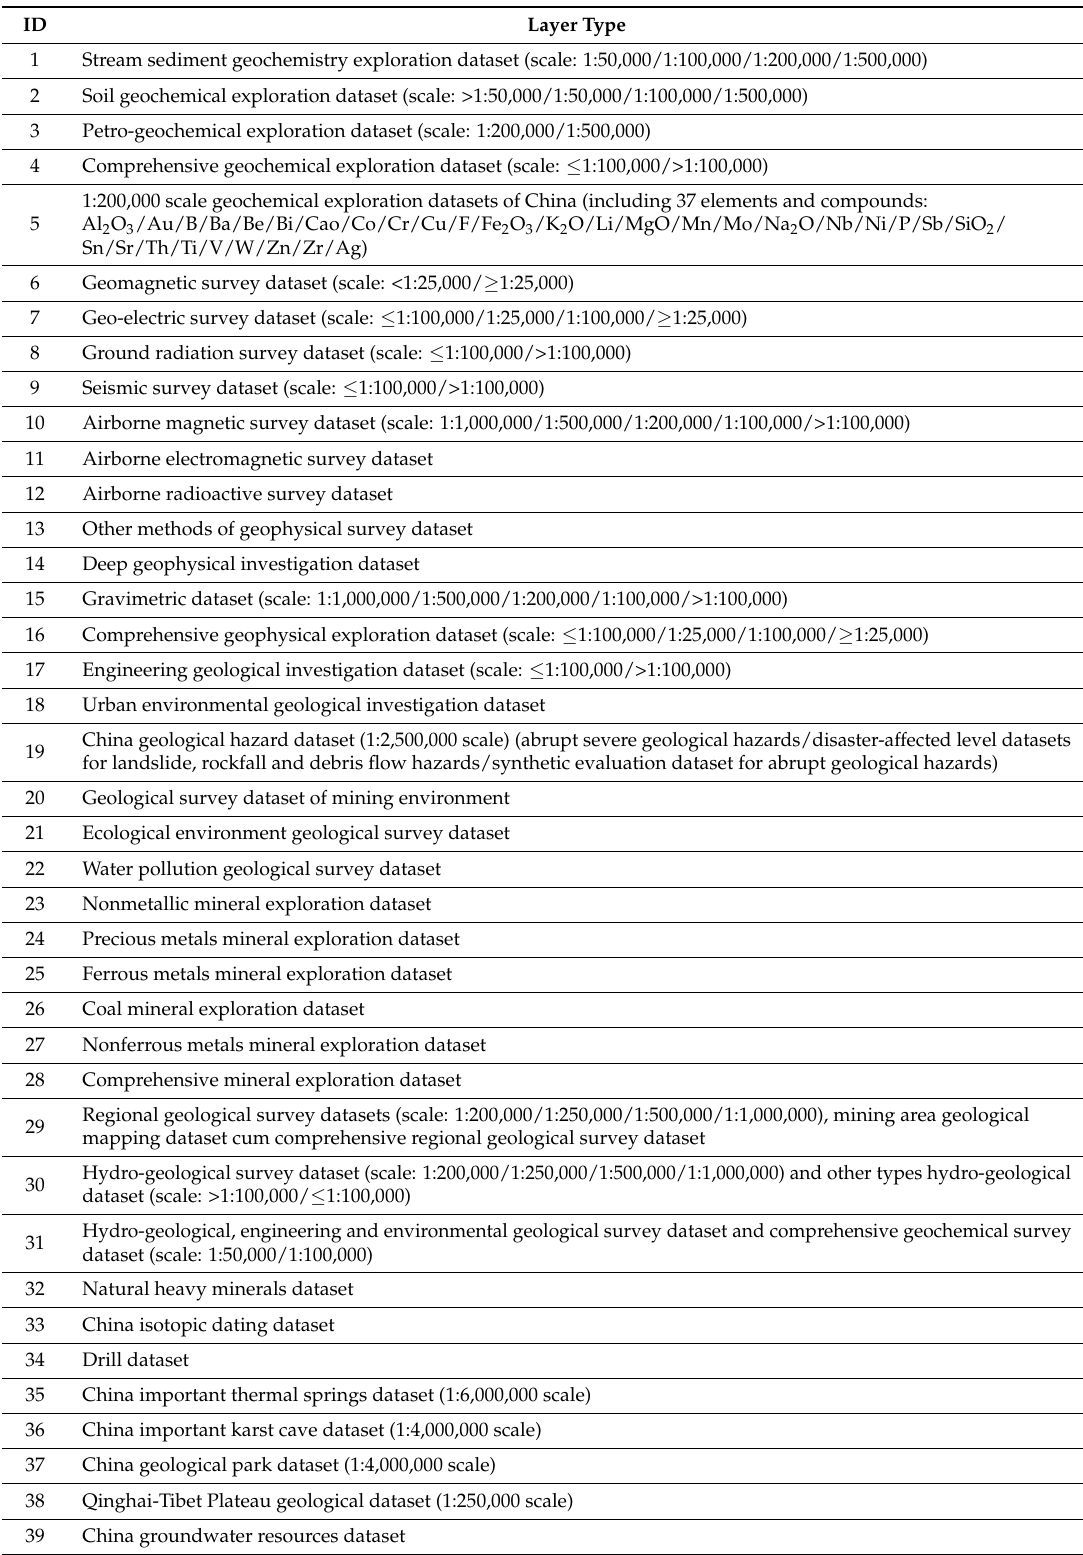
Table 1. Data catalogues of China Geological Survey Information Service